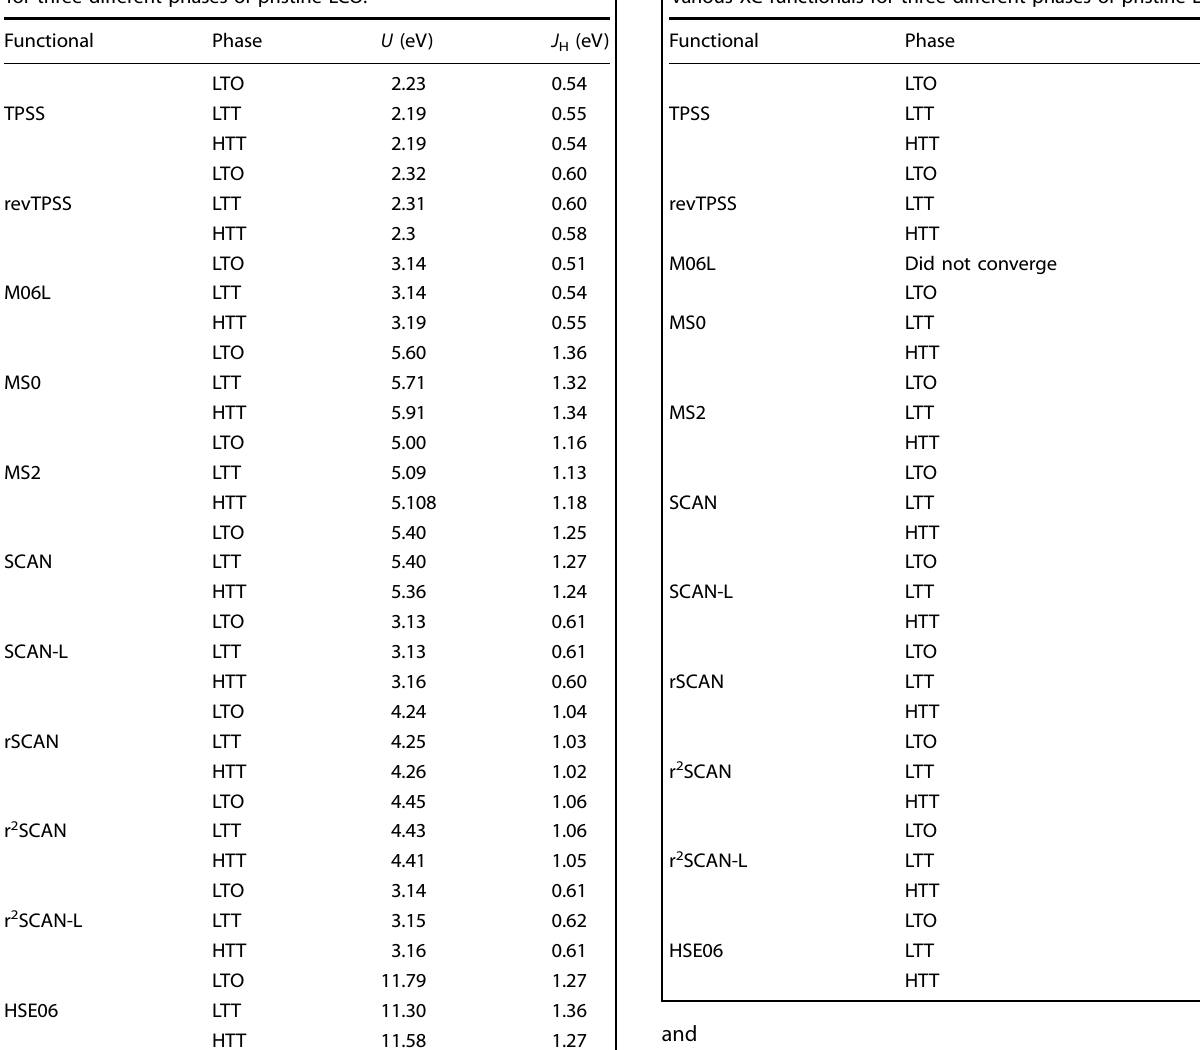
Table 2. Theoretically predicted values of exchange coupling using various XC functionals for three different phases of pristine